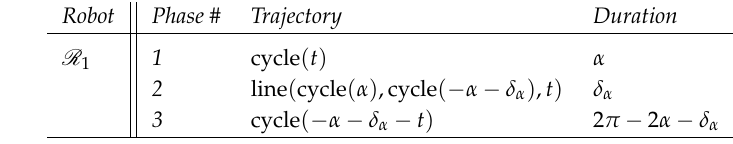
Figure 5. Robot Trajectories for algorithms A 1 , A 2 , A (cid:48) . The depicted trajectories show the search of 2 the circle, and not the evacuation step that is performed once the exit is found. Arcs that are searched by both robots are also searched simultaneously, i.e., robots are co-located and search